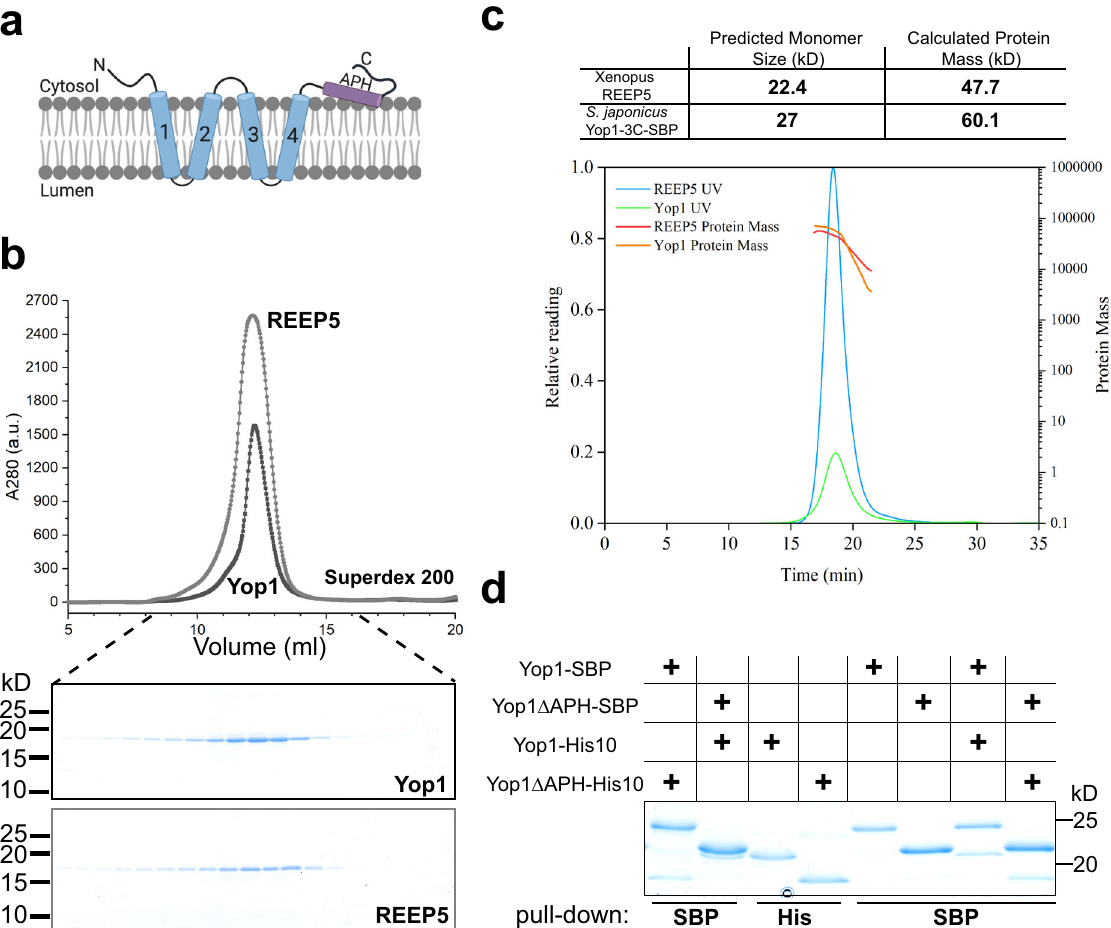
Fig. 1 REEPs form dimers. a Proposed membrane topology of the REEPs and Rtns. The four hydrophobic transmembrane segments (TMs) are numbered and shown in blue; the predicted amphipathic helix (APH) is shown in purple. b SEC of S. japonicus Yop1 and Xenopus laevis REEP5 puri fi ed in the detergent DDM. The experiment was performed four times. The top panel shows the absorbance at 280 nm. Fractions of the eluate were analyzed by SDS-PAGE, and stained with Coomassie blue (lower panels). c SEC-MALS analysis of puri fi ed REEP5 and Yop1-3C-SBP, analyzed in DDM. Absorbance at 280 nm (UV) was normalized relative to the maximum reading of REEP5 (left axis). The calculated protein mass is shown across the peaks (right axis). The table on top shows the calculated and predicted monomer masses. d SBP-tagged full-length Yop1 or Yop1 lacking the APH (Yop1 Δ APH) was co-expressed with His- tagged full-length Yop1 or Yop1 Δ APH. DDM-solubilized membrane fractions were incubated with streptavidin beads and the bound material analyzed by SDS-PAGE and Coomassie-blue staining. As a control, SBP- and His-tagged Yop1 were individually expressed and puri fi ed. The experiment was performed three